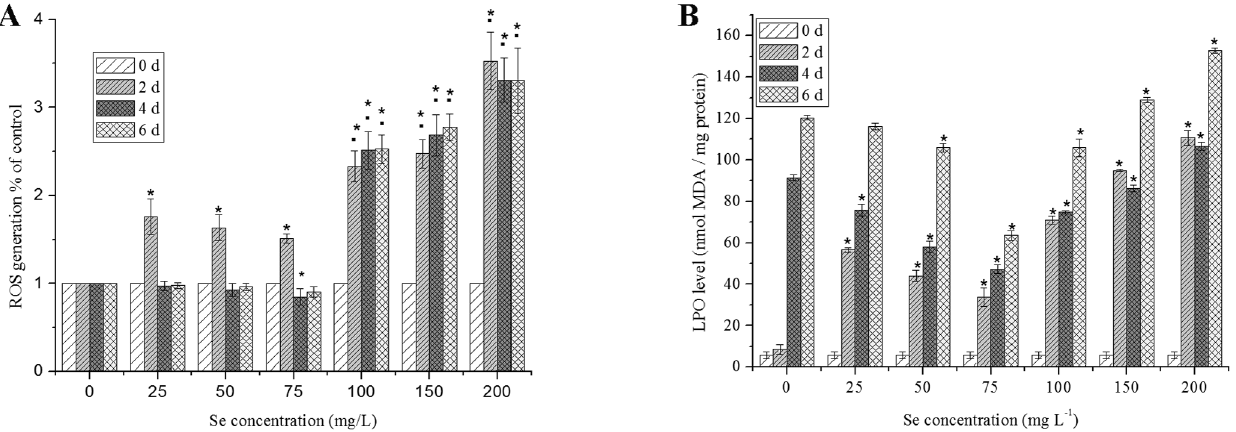
N in figure means significant